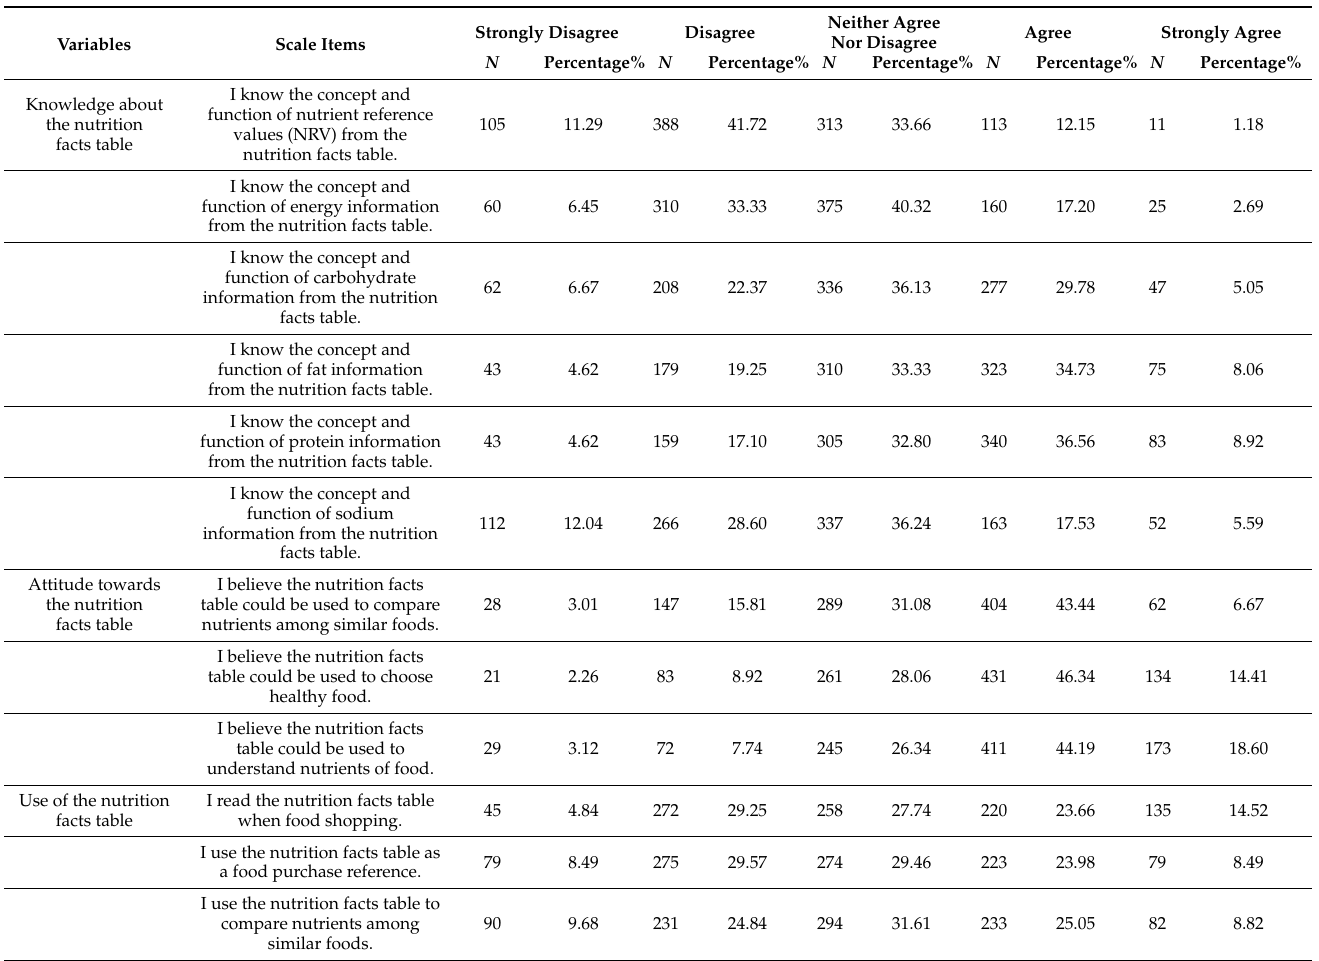
Table 3. Description of variables and summary statistics.